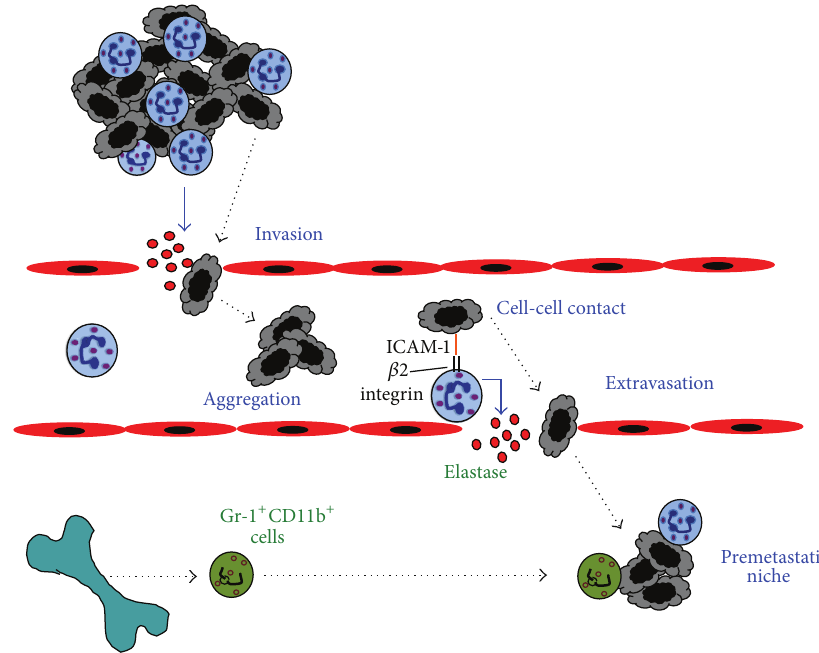
Figure 3: Neutrophils can promote tumor cell invasion and metastasis. Tumor-associated neutrophils (TANs) help tumor invasion in several ways. TANs can secrete enzymes, such as elastase (red dots), that degrade the basement membrane and promote tumor cell invasion through the basement membrane. Once in circulation, neutrophils can also help tumor cells to survive by inducing tumor cell aggregation. Circulating tumor cells can directly adhere to arrested neutrophils via the adhesion molecule ICAM-1 on the tumor cells, and 𝛽 2 integrins on neutrophils. This cell-cell interaction promotes extravasation of the tumor cells. Bone marrow-derived cells including neutrophil precursors (Gr-1 + CD11b + cells) migrate to premetastatic niches where they secrete factors that promote tumor cell growth. Blue arrows denote molecules secreted by cells. Dotted lines denote cell